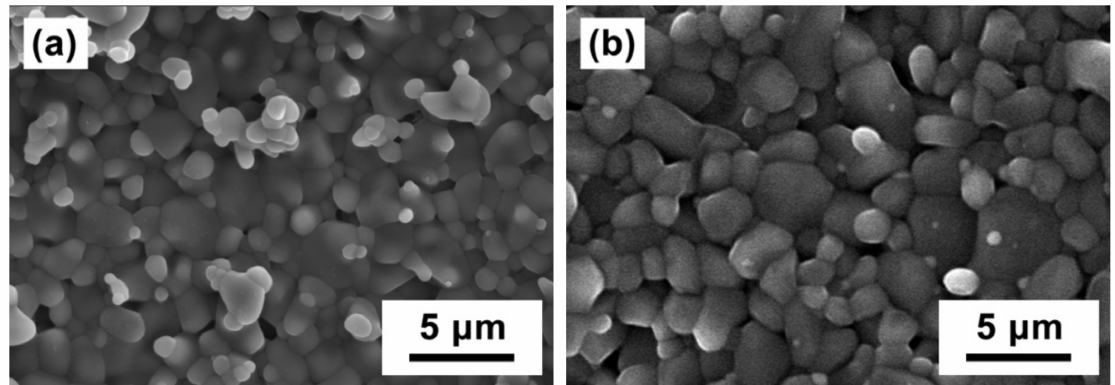
Figure 7. Quantitatively characterize the relative densities of sample units. ( a ): SEM micrograph of laser-sintered alumina. ( b ): Furnace-sintered alumina with a relative density of 98%.